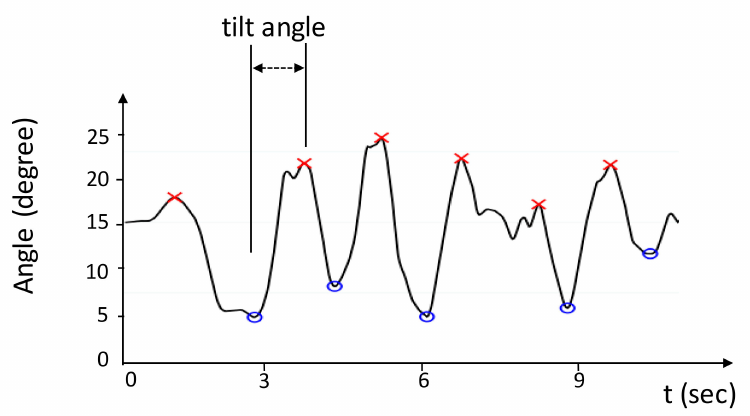
Figure 8. Illustration of the trunk tilt angle measured from back_trunk on the sagittal plane. The angle from a valley point (blue circle) to a peak point (red cross) represented the tilt angle through which the participant swung the trunk to maintain balance.